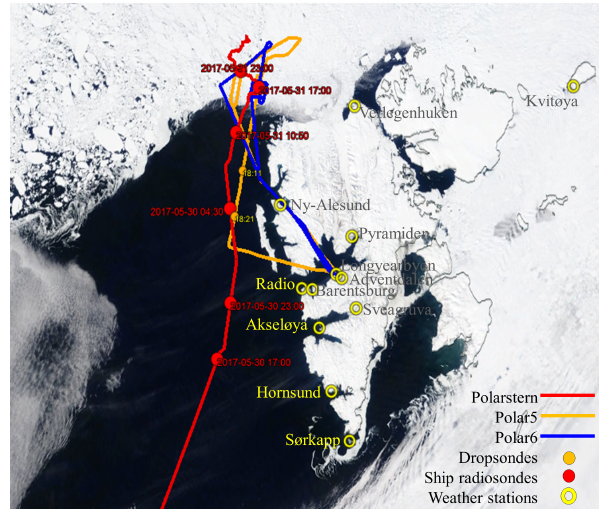
Figure 1. Satellite visible image (MODIS-corrected reflectance from NASA Worldview, https://worldview.earthdata.nasa.gov, last access: 25 January 2022) of the study area at ∼ 12:00UTC, 31 May 2017. Lines and points show ship and aircraft tracks, loca- tions of dropsondes and radiosonde launches, and weather stations on